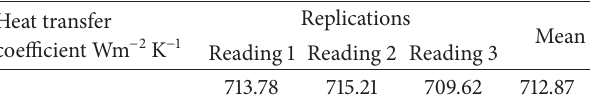
Table 8: Results of confirmation